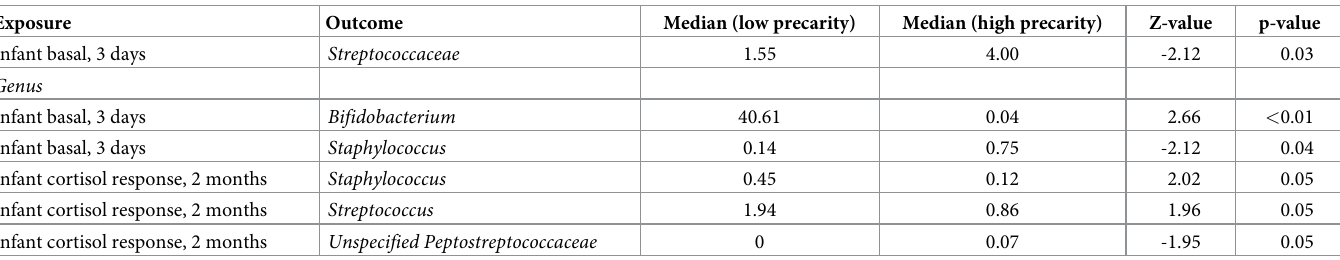
Table shows all significant results for bivariate analyses of precarity measures and relative abundance of phylum, family, and genus taxa at p � 0.05 Gray cells are significant post-FDR correction.